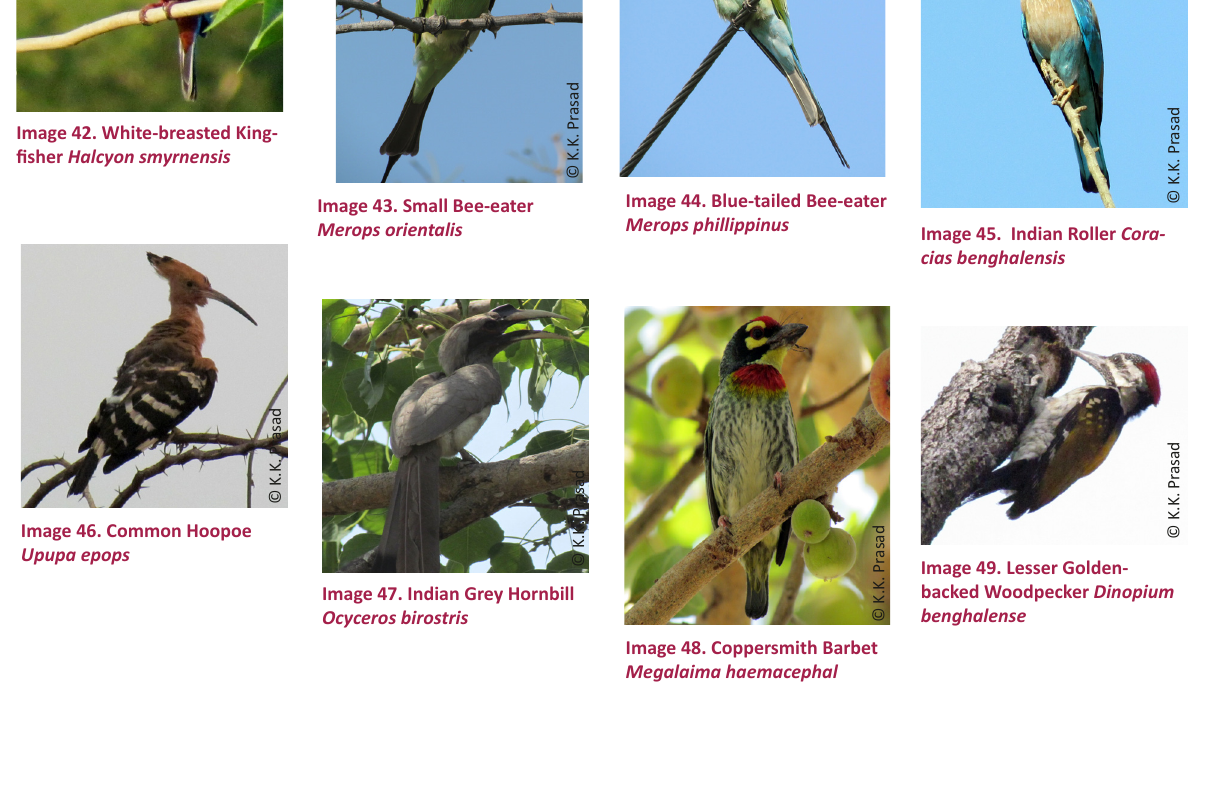
Image 39. Brainfever Bird Hiero- coccyx varius